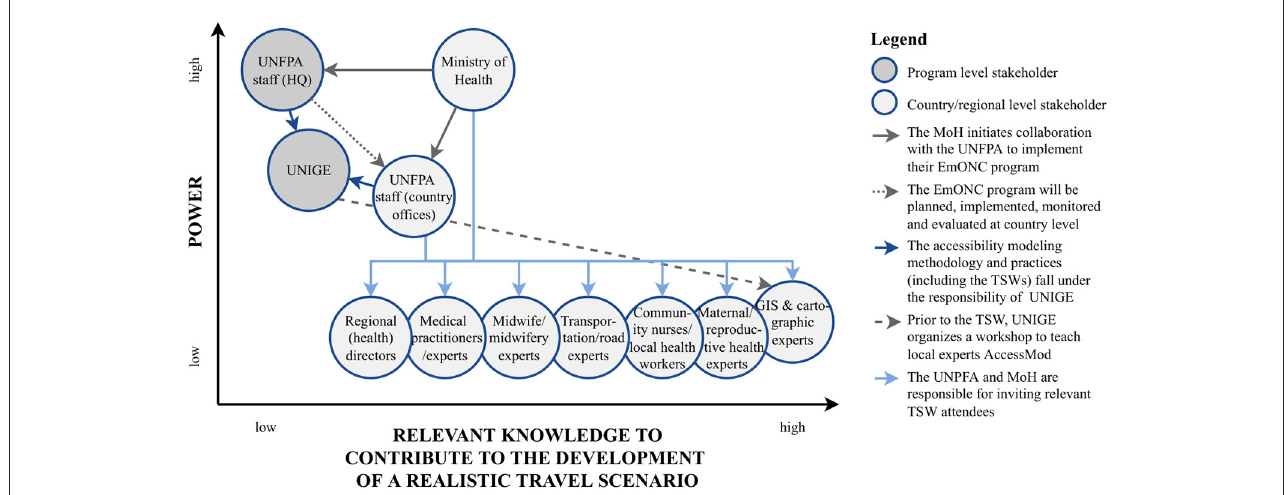
FIGURE3 Power-knowledge grid of identified stakeholder groups. The stakeholder division over the power axis is based on the TSW organization within the UNFPA EmONC development approach and further explained/substantiated by the arrows within the figure. The level of relevant knowledge attributed to each stakeholder group is based on the survey results (Supplementary Table 2).